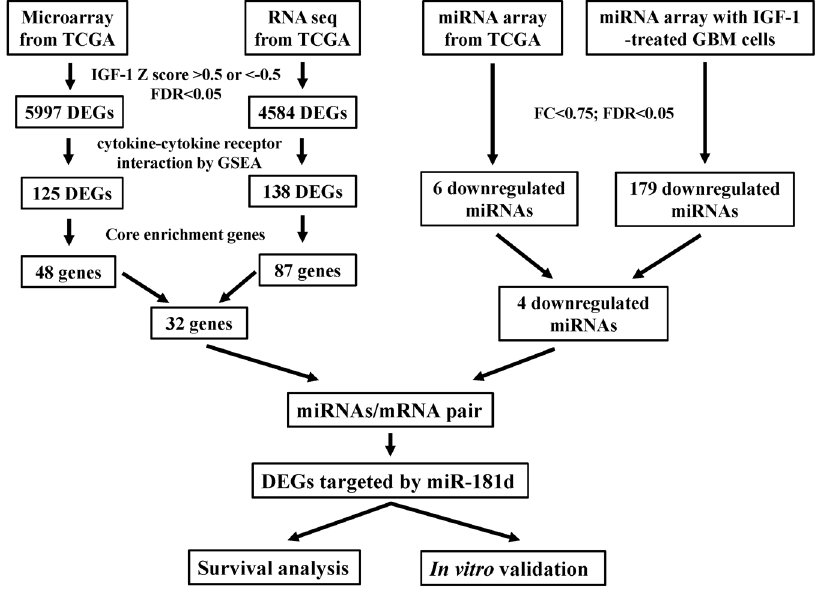
Figure 1. Flowcharts for analyzing the insulin-like growth factor (IGF)-1 mediated messenger (m)RNA/ micro (mi)RNA networks in glioblastoma multiforme (GBM). DEGs, differentially expressed genes, FDR, false discovery rate; MC, multiple of change. MC, multiple of